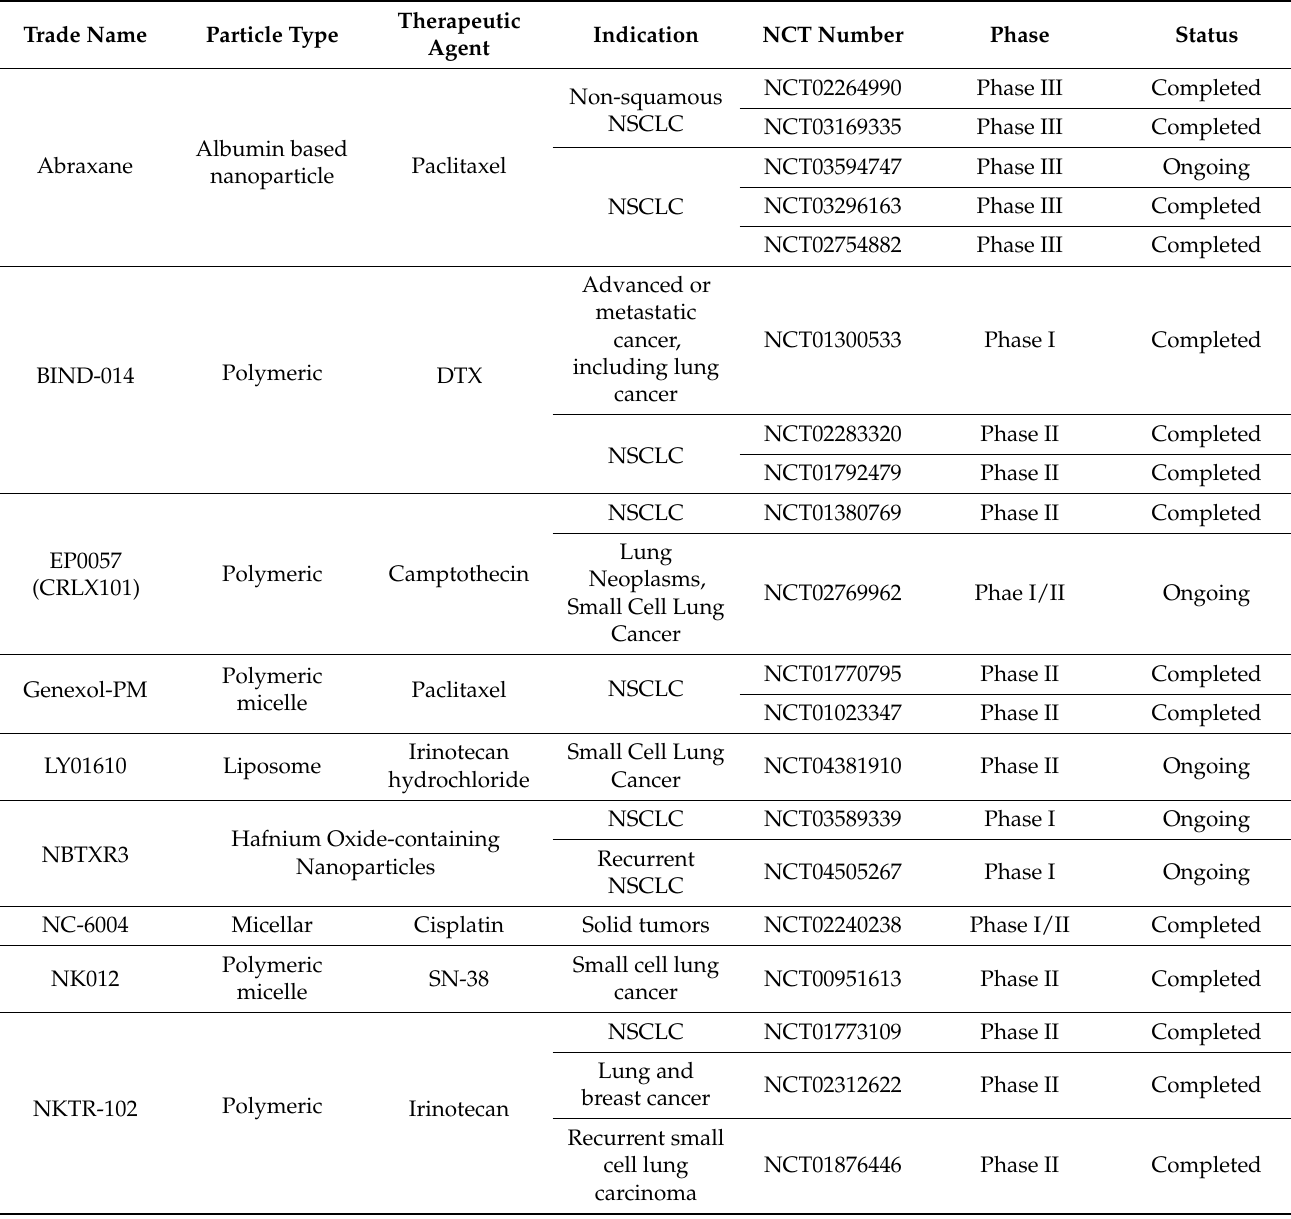
Table 4. Clinical trials performed with nanotherapeutics in lung cancer